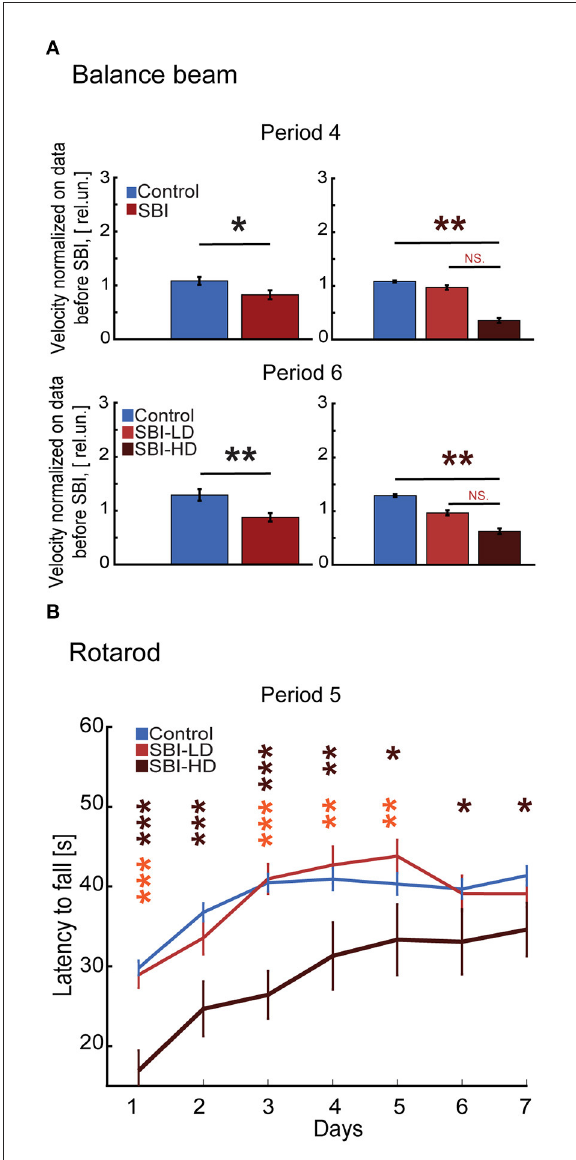
FIGURE4 SBI chronically alters fine skill motor execution. (A) Illustrates the velocity reached by control ( n = 22) and SBI ( n = 30) while crossing the wooden beam a week (period 4) and 4 weeks (period 6) after SBI. Data were normalized to velocity reached before SBI. Data are shown in relative units (rel.un.). In addition, the data shows the balance beam performance when the SBI group was split into SBI-HD ( n = 7) and SBI-LD ( n = 8) and contrasted to control ( n = 22). (B) The performance trajectories on a rotarod of control ( n = 21), SBI-HD ( n = 6), and SBI-LD ( n = 7) after 3 weeks post-SBI (period 5). Data is presented in average durations (mean ± S.E.M.) of 5 trials per individual per day. We used the Kruskal–Wallis test and Dunn’s with post hoc Bonferroni correction to determine the effect of blast injury on fine motor skills. * p < 0.05, ** p < 0.01, *** p < 0.001, and non-significant statistical differences (N.S). Brown asterisks depict differences between SBI-HD and sham mice, and the orange asterisk display differences between SBI-HD and SBI-LD